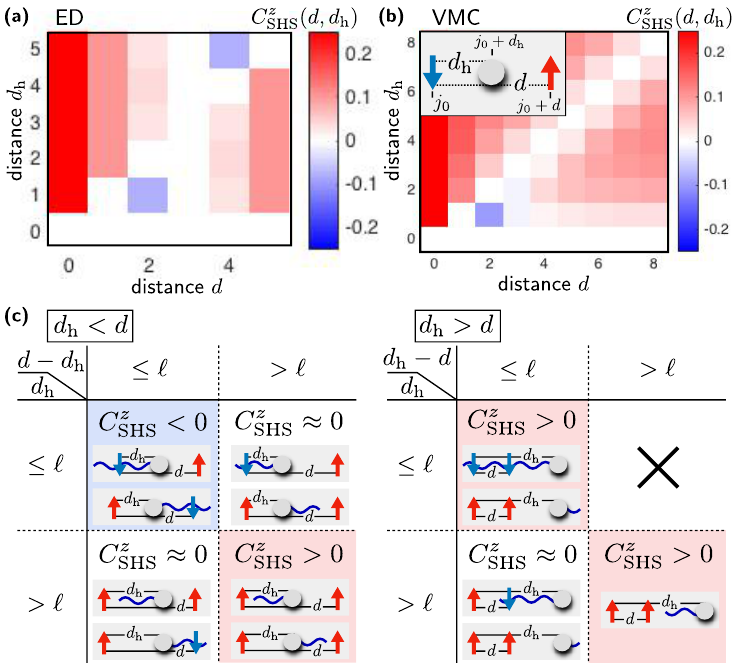
Figure 2: Signatures of meson formation. We calculate spin-hole-spin correla- ( d , d ) , calculated using ED in a tions for t = 3 J . (a) The three-point function C z h SHS 6 × 3 system periodic along x , changes sign at d = 3. This indicates the presence of a geometric string with an average length around one. (b) The same behavior is predicted in a 16 × 8 periodic system by the trial wavefunction in Eq. (4) which we = ( π/ 2, π/ 2 ) , Φ = ± 0.4 π , B = 0.44 using VMC methods. (c) The evaluated at k MP st ( d , d ) observed in (a) and (b) can be understood from the string structure of C z h SHS − d to the typical string length (cid:96) picture by comparing the distances d , d − d and d h h h < d and d > d . Purple wavy lines are schematic and distinguishing the two cases d h h representations of the strings. Spin correlations change sign when crossing either end of the string. Blue spins are part of the geometric string and have changed the ( d , d ) . One has to average over the sublattice, introducing negative signs in C z h SHS opposite orientations of the string relative to the hole, Σ = ± (cid:96) , to estimate the value of the